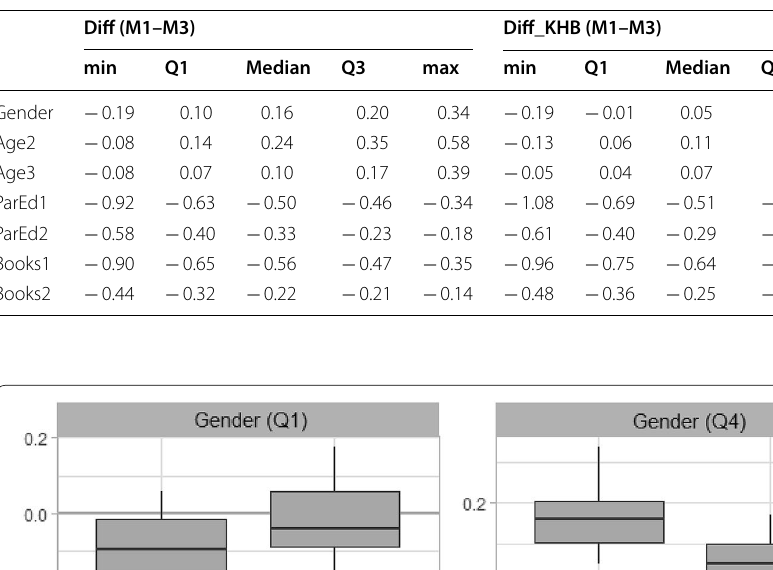
Table 3 5-number summaries for conventional differences and KHB differences, by variable [Q4]